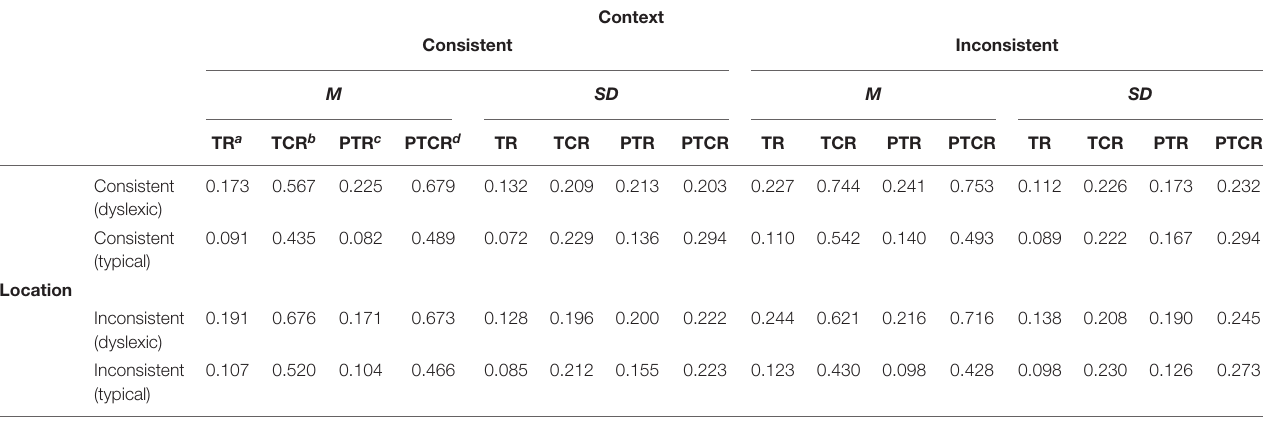
c Raw scores. d Higher scores represent greater likelihood of reading disability. e Discontinue rule: two incorrectly typed responses in a row. TABLE 2 | Summary of subject-weighted mean error proportions in the training recognition task and interspersed cued-recall trials, post-training recognition and cued-recall